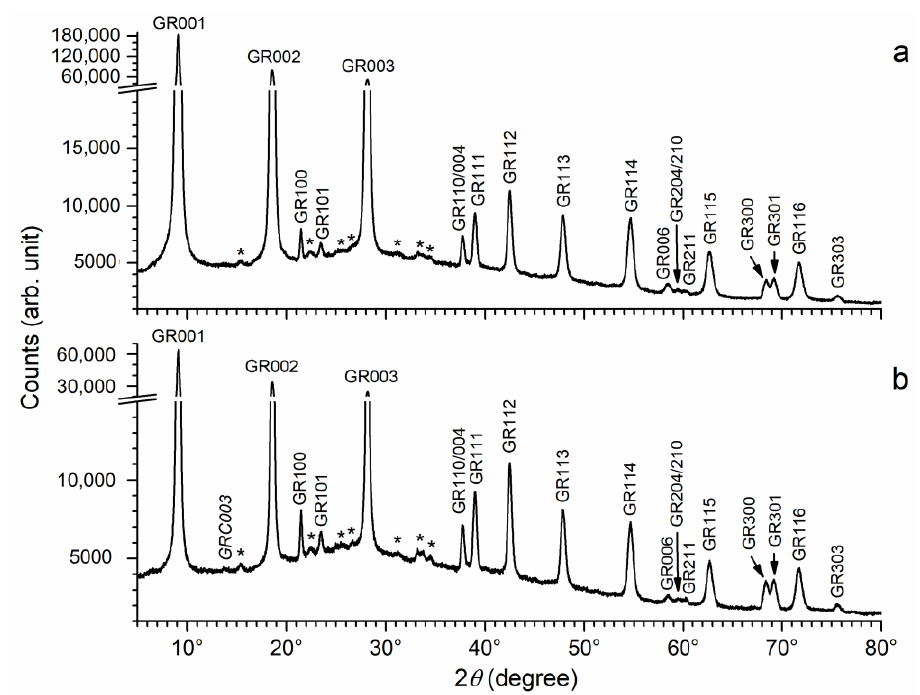
Figure 5. XRD pattern of the precipitates obtained with bacterial strain Bacillus IVA016 ( a ) and Pseudoalteromonas IIIA004 ( b ) after 1 week of ageing at RT. GR = GR(SO 42 − ) and GRC = GR(CO 32 − ), with the corresponding Miller index. * = unidentified peaks.